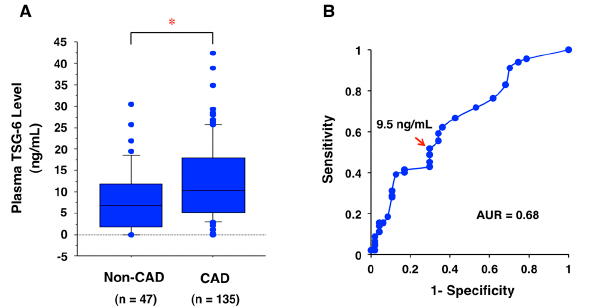
Figure 5. Biomarker of CAD using plasma TSG-6 levels at the onset of acute coronary syndrome. ( A ) Plasma TSG-6 levels are significantly higher in 135 CAD patients than 47 non-CAD subjects. Data are shown as median (center line in box) with 25th percentile (lower line of box), 75th percentile (upper line in box), 10th percentile (bars below box), and 90th percentile (bars above box). Unpaired Student’s t test was used for statistical analysis. * p = 0.0013. The graph was modified from the graph shown in